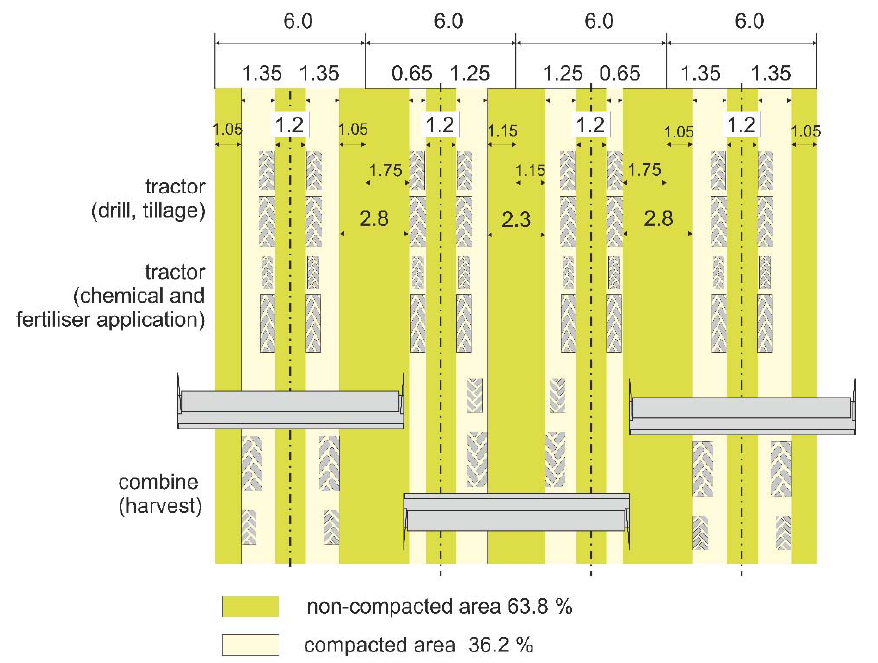
Figure 2. Tramlines (size in meters) of used machines without adaptation of track width (CTF— experimental field in Kolinany).